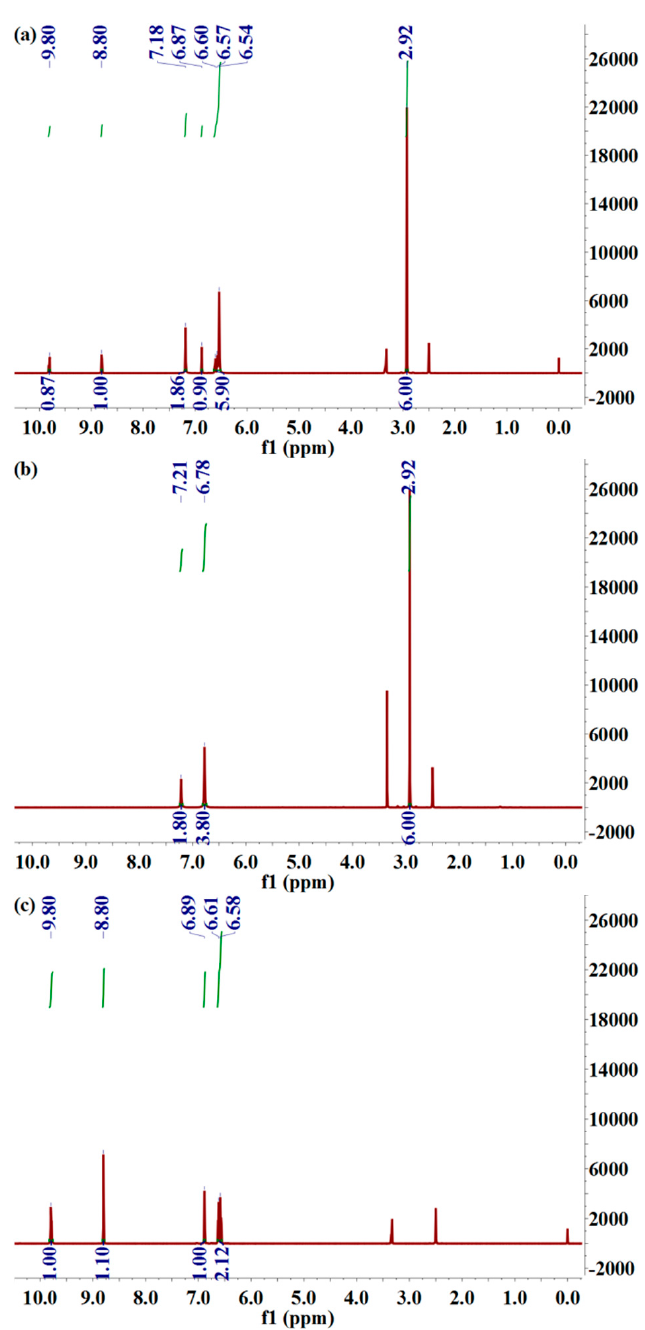
Figure 3. 1 H NMR spectra for drug–drug crystal of ( a ) MET–DBS, ( b ) MET·HCl, and ( c ) DBS·K.